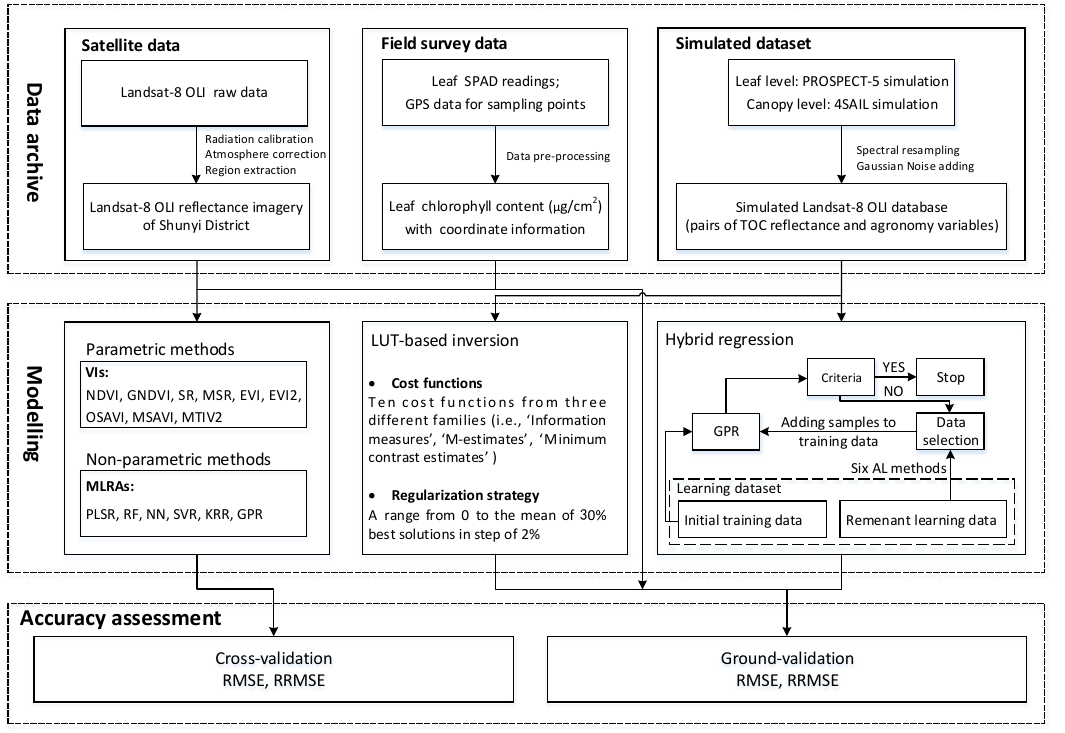
Figure 2. A schematic diagram of leaf chlorophyll content (LCC) retrieval methods adopted in the present